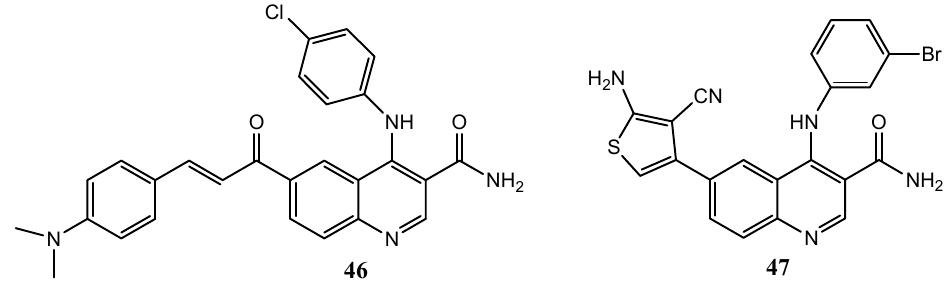
Figure 22. 4-anilino-3-carboxyamide derivatives as EGFR inhibitors [119,120].